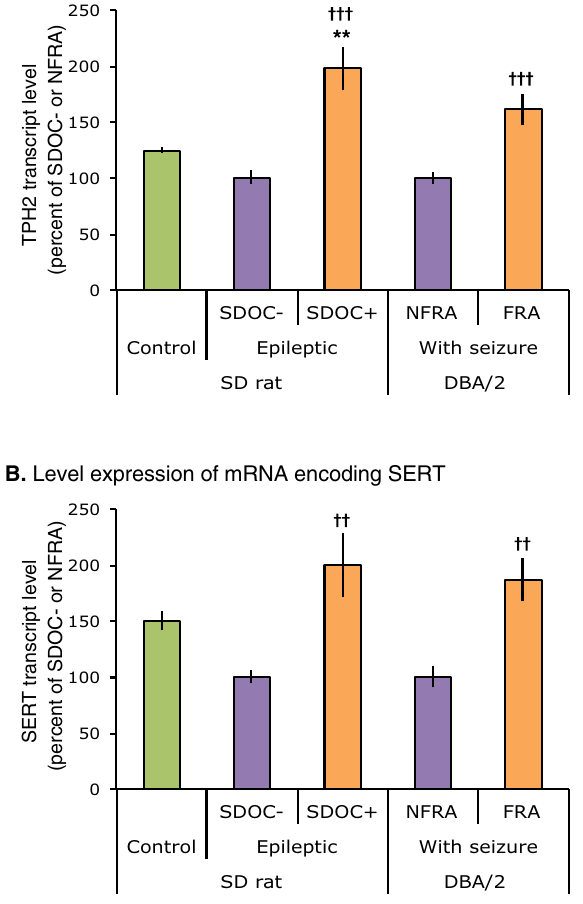
Figure 5. TPH2 and SERT mRNA transcript levels were measured in the brainstem of EPI rats and DBA/2 mice. Changes in brainstem levels of TPH2 ( A ) and SERT ( B ) transcripts were measured in EPI rats and DBA/2 mice at 8 weeks post-SE and 2–3 min after audiogenic seizure (AGS), respectively. In contrast to EPI rats, DBA/2 mice had no history of seizure before AGS. Some mice developed fatal respiratory arrest (DBA/2 with FRA) or non-fatal respiratory arrest (DBA/2 with NFRA) after AGS. TPH2 and SERT transcript levels in EPI/ SDOC + rats and in DBA/2 mice with FRA are expressed as percentage (mean ± SEM) of EPI/SDOC− rats and DBA/2 mice with NFRA, respectively (n = 5 in each group). †P < 0.05, ††: P < 0.01, †††: P < 0.001, in comparison to EPI/SDOC− rats and DBA/2 mice with FRA. *P < 0.05; **P < 0.01, in comparison to control